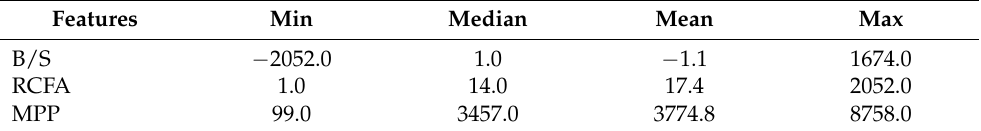
Table 6. Descriptive